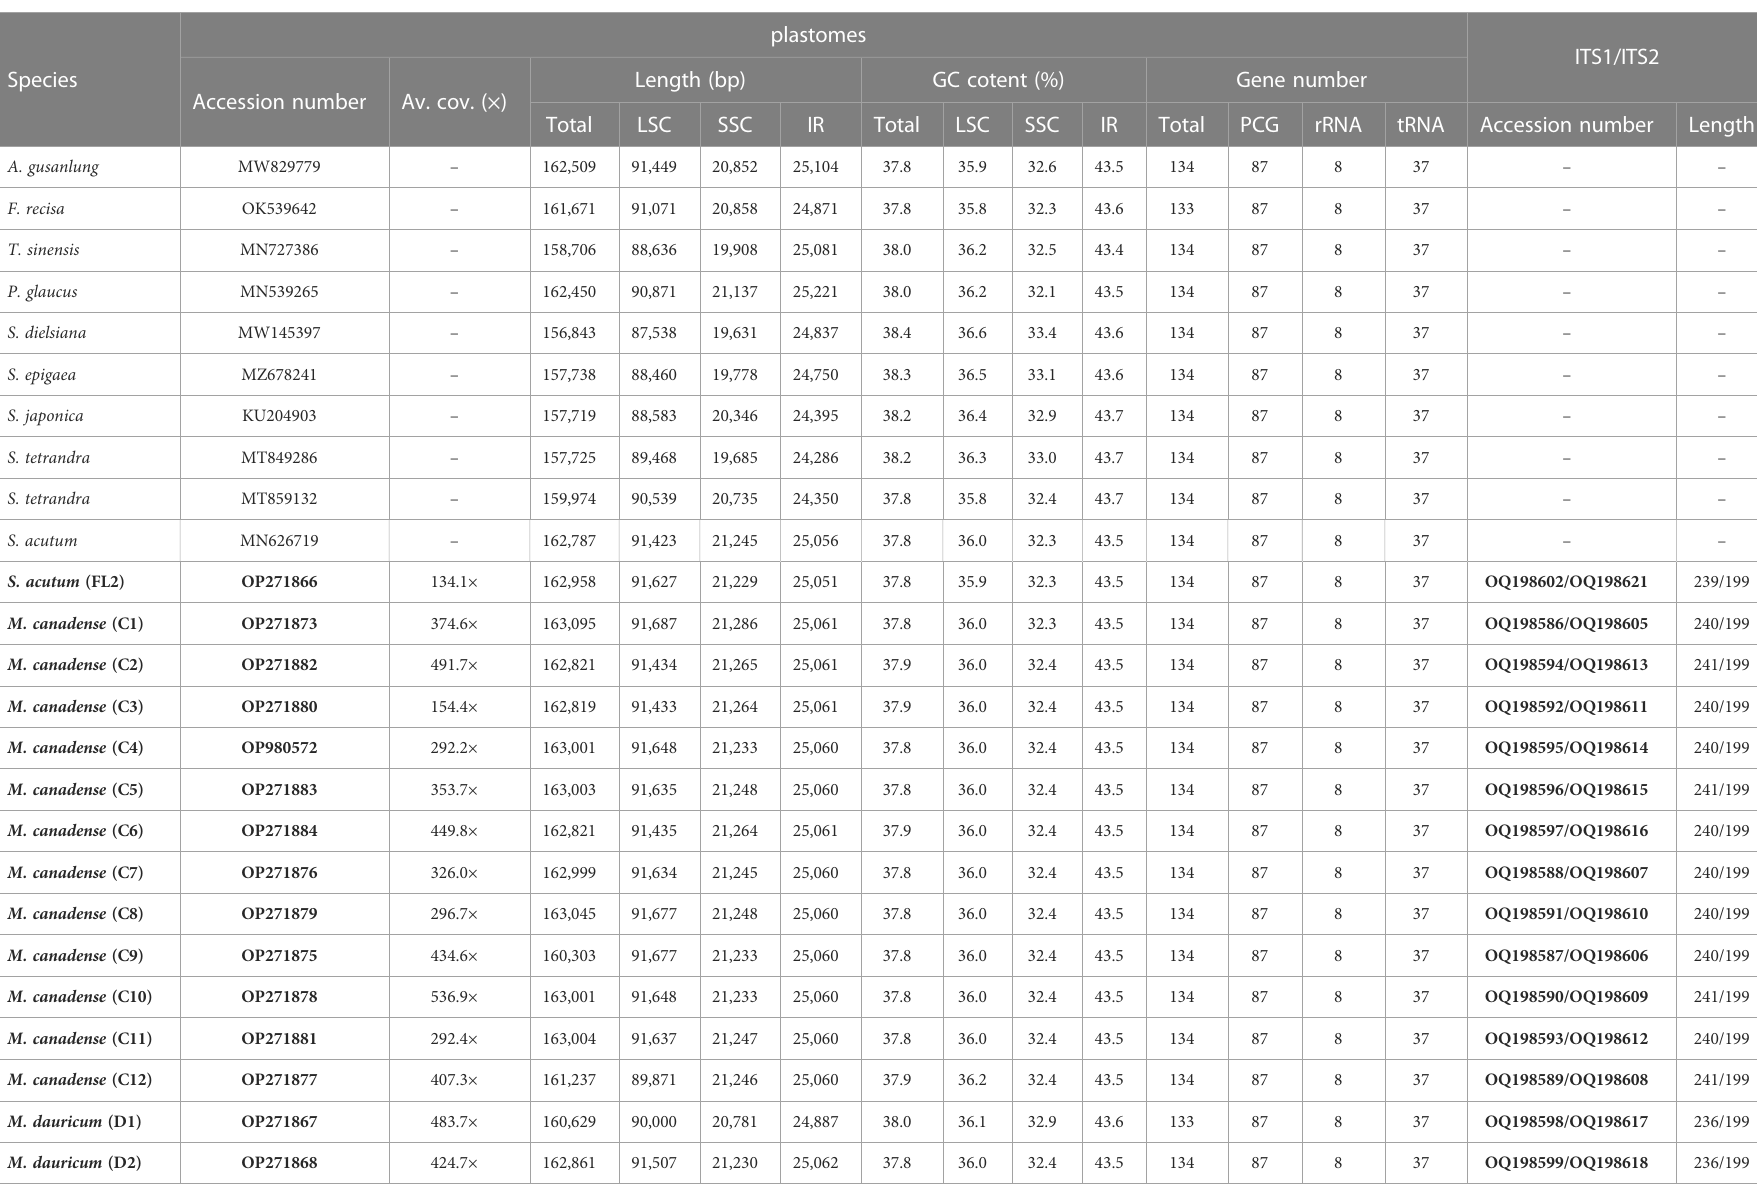
TABLE 2 The basic characteristics of plastomes and ITS1&ITS2 sequences of Menispermaceae species.